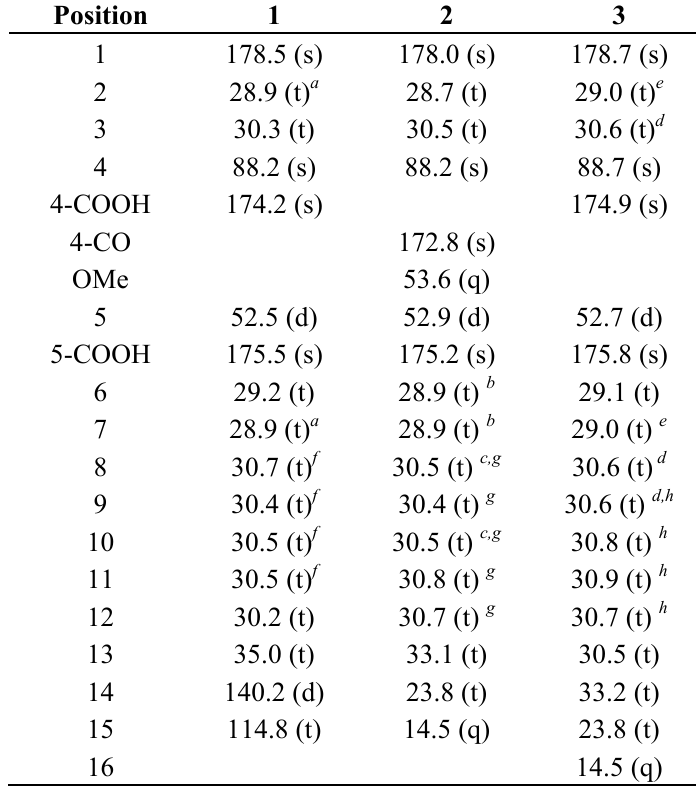
OD) of compounds 1 – 3 3